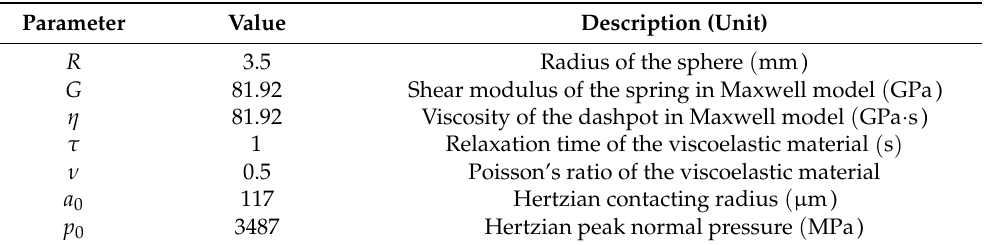
Table 1. Parameters used in the simulation of a rigid sphere indenting a viscoelastic half-space (Maxwell model) under constant normal